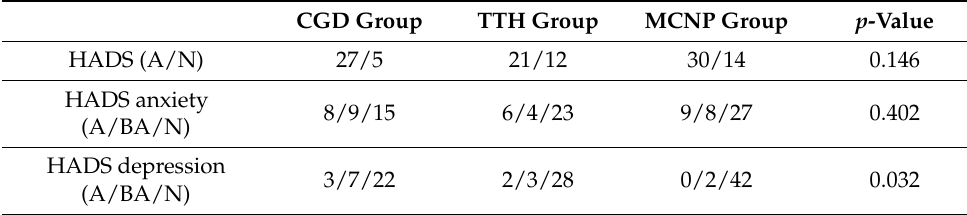
Table 4. Correlation analysis. Pain